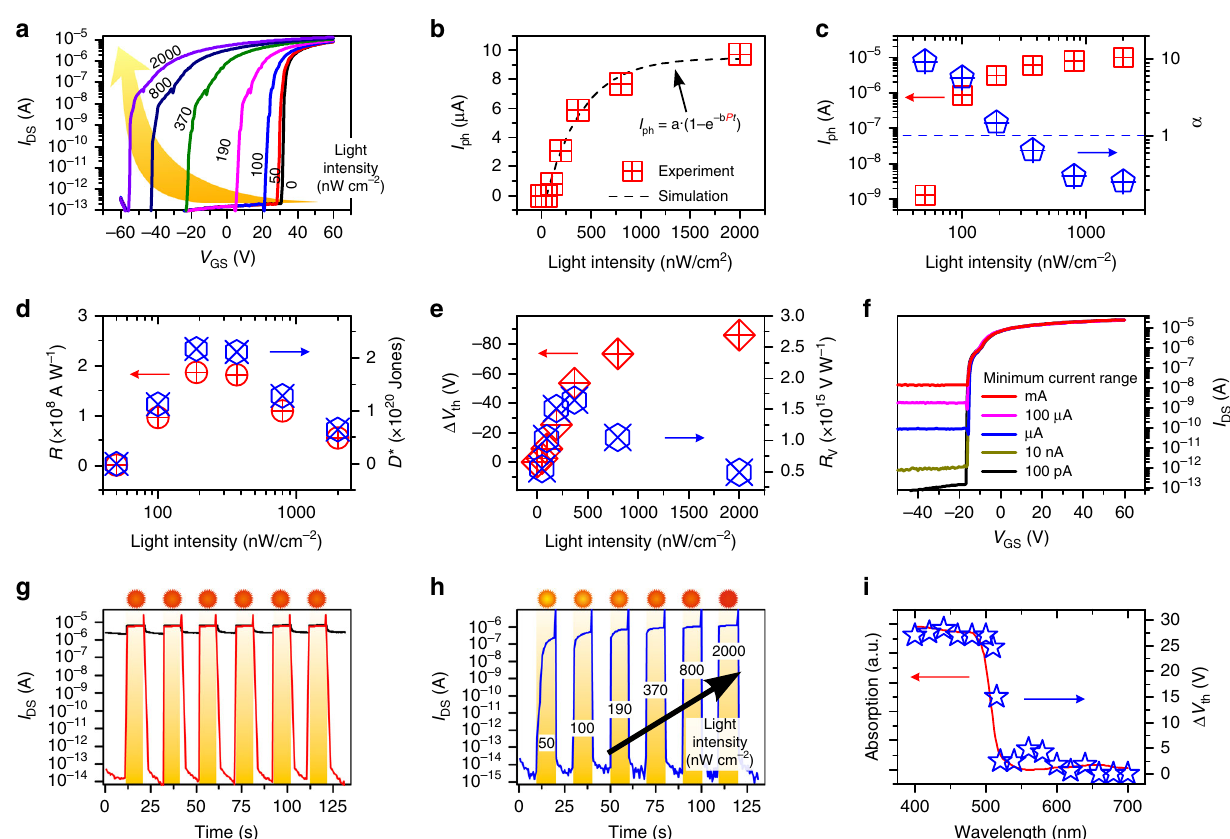
Fig. 3 Photodetection performance of CdS NR MPT. a Electrical transfer characteristics of the CdS NR phototransistor measured in the dark after it was irradiated with different light intensities of 0 – 2000 nW cm − 2 for 10 s. V DS was fi xed at 0.6 V during measurements. b Photocurrent as a function of light intensity in linear coordinate at V GS = 30 V. c Photocurrent and corresponding α as a function of light intensity in double logarithmic coordinates at V GS = 30 V. d R , D *, and e Δ V th , R V extracted from ( a ). f Transfer characteristics measured in different minimum current ranges of the sourcemeter from 100 pA to 1 mA. g Photoresponse curves of the CdS NR phototransistor measured under pulsed light irradiation (2000 nW cm − 2 ). A fi xed gate voltage (corresponding to black curve) or a periodically pulsed gate voltage (corresponding to red curve) was applied during measurements. h Photoresponse curve of the CdS NR phototransistor measured under pulsed light irradiation with a gradually increased light intensity from 50 to 2000 nW cm − 2 . A periodic pulsed gate voltage was applied. i Spectral response of the CdS NR phototransistor measured in the wavelength range 400 – 700 nm, along with the light absorption spectrum of NRs for